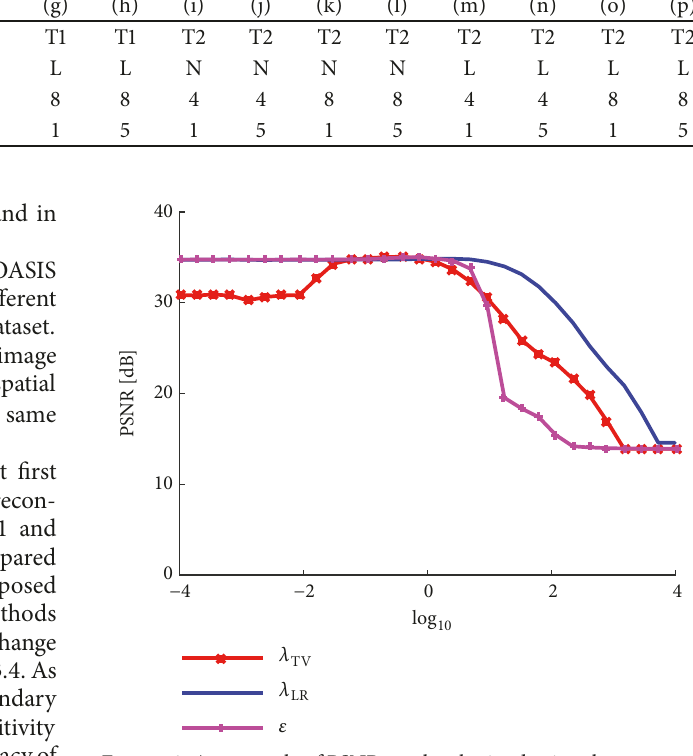
Figure 3: An example of PSNR results obtained using the proposed method in terms of the parameters 𝜆 TV , 𝜆 LR ,𝑎𝑛𝑑 𝜖 . The input image was image (a) in Table